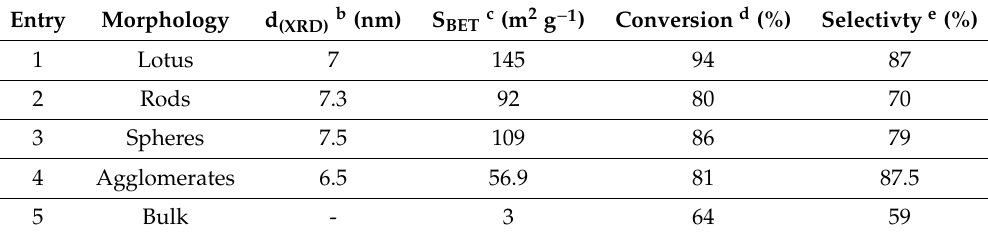
Figure 13. Combined use of MnO 2 and t -BHP for the oxidation of some terpenes (adapted from reference [69]). Table 20. Allylic oxidation of α -pinene. Comparison of various shaped MnO 2 catalysts a (adapted from reference [70]).